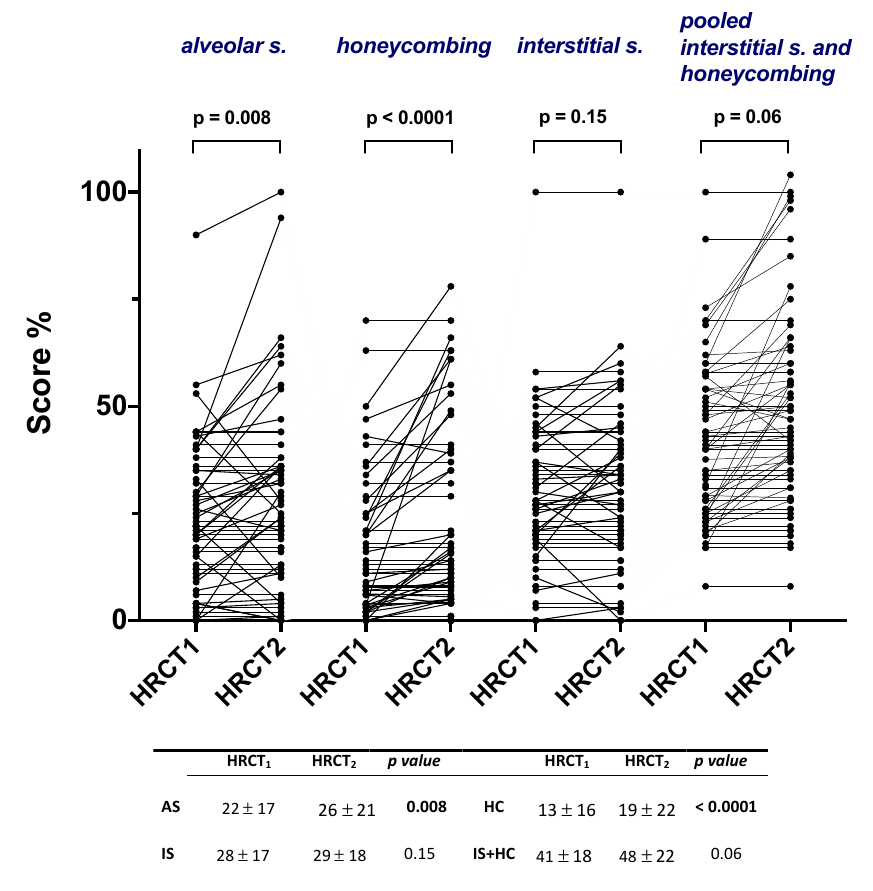
Figure 2. Alveolar score, interstitial score, honeycombing and pooled interstitial score and honeycombing at treatment initiation (HRCT1) and after one year of treatment (HRCT2) in the entire study population. Values in the table below are expressed as mean and standard deviations. P values refer to comparisons between HRCT1 and HRCT2.